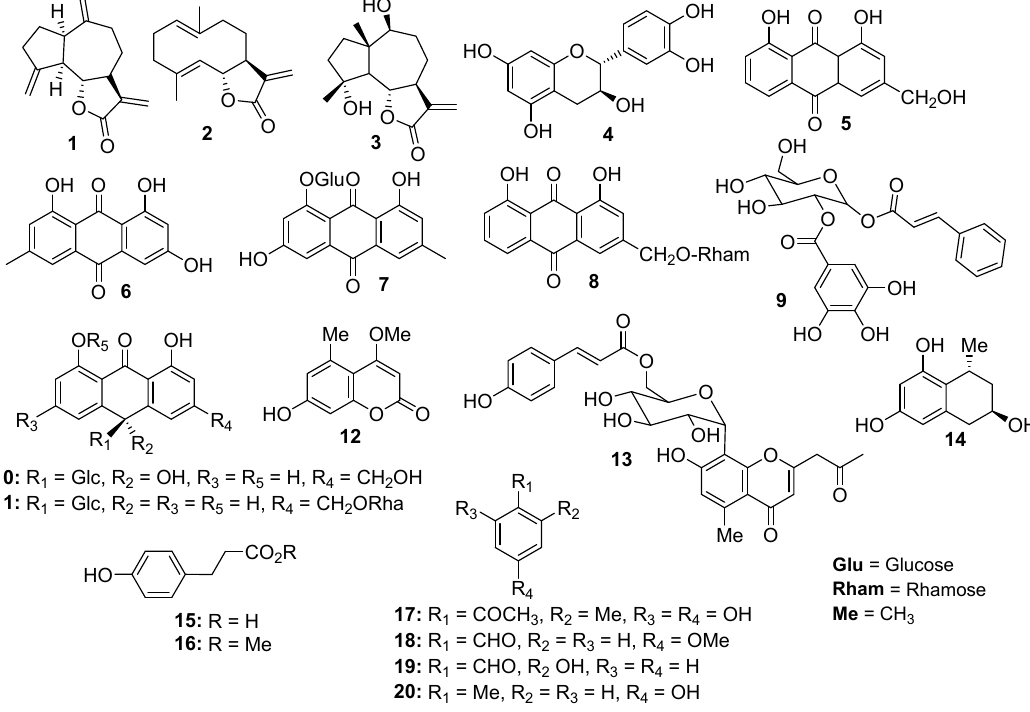
Figure 1. Structures of the compounds 1 – 9 isolated from L. shawii and 10 – 20 isolated from A. vera